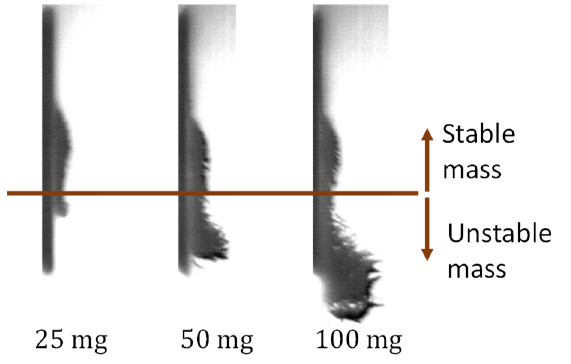
Figure 6. Bulk of particles of three amounts, after the field is turned off for 0.5 s.